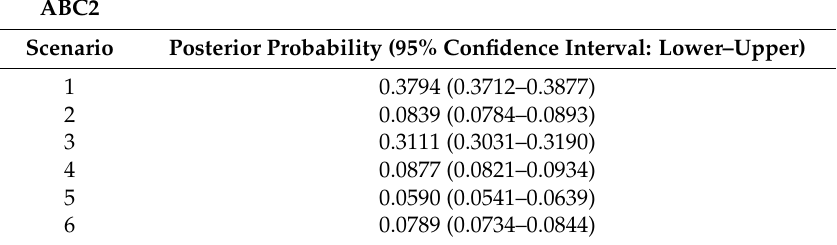
Table 5. Posterior probability of each scenario in ABC2 and its 95% hyper probability density (HPD) based on the logistic estimate by DIYABC v2.0 [42,43]. The scenarios tested in ABC2 are shown in Figure 4. ABC2 Scenario Posterior Probability (95% Confidence Interval: